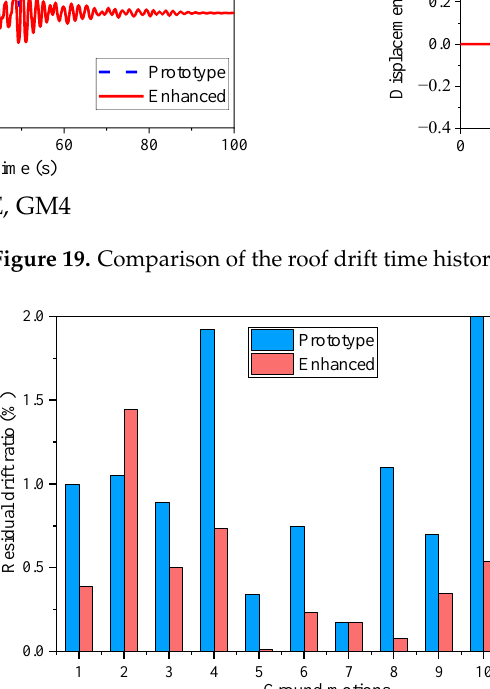
Figure 20. Comparison of the maximum residual inter-story drift ratios. Table 4 analyzes the effect of PSCRSW on the structural performance from the per- spective of energy dissipation, in which the energy dissipated by the beam and column hinges were compared. For all the records, both the energy dissipated by beams and columns was significantly reduced, with the total energy, respectively, decreased by 58% and 99%. Therefore, it can be concluded that the damages that occurred in beams and columns are significantly mitigated, which further illustrates the effectiveness of PSCRSW in enhancing structural seismic resilience. Table 4. The comparison of energy dissipated by the frame members.